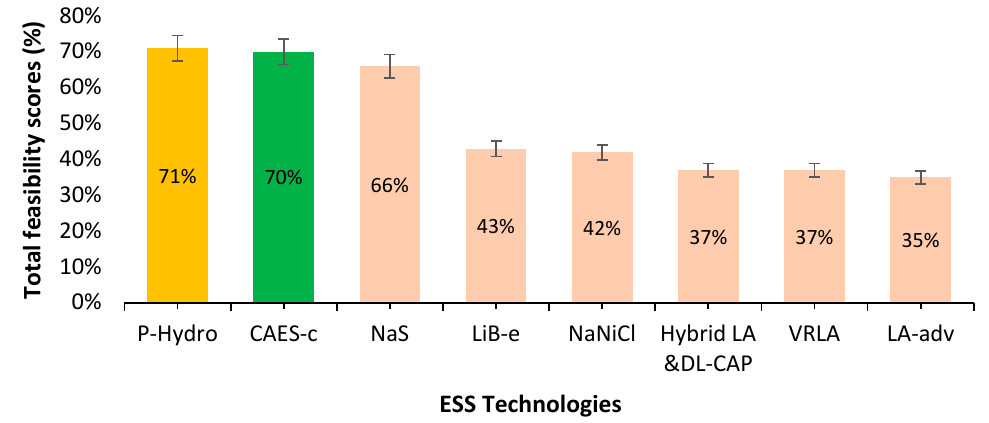
Figure 5. Analysis of the feasibility scores (%) of different ESSs applicable at central or bulk storage for a weight factor of 1, considering the four categories of the chosen criteria (ALCM), and total installation cost (USD/kW) or (USD/kWh).